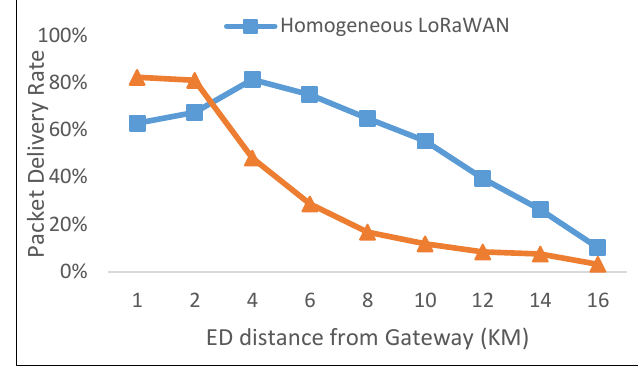
Figure 4: Uplink delivery rate variation with distance from the gateway.